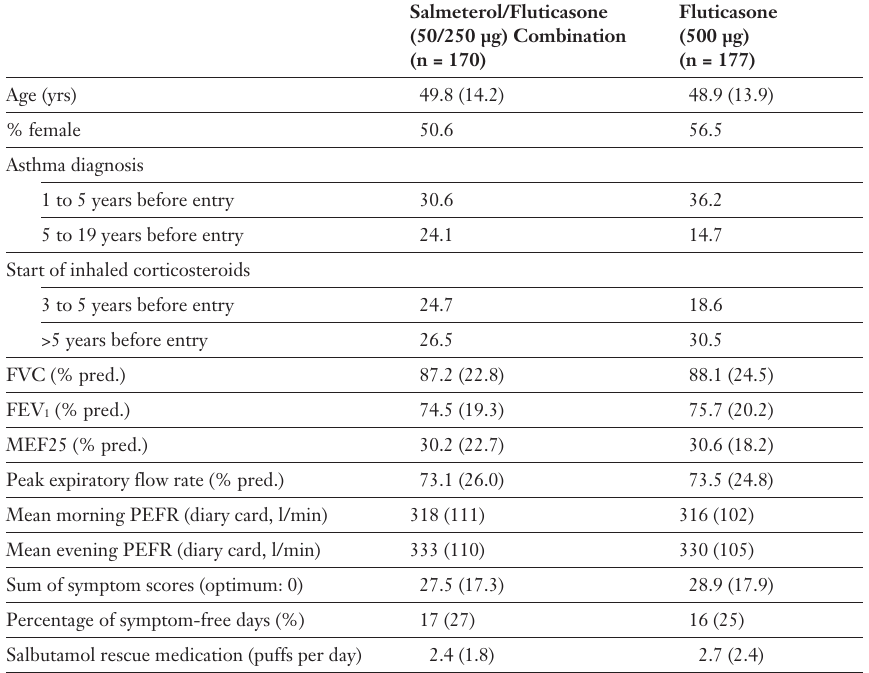
Demographic data, respiratory function tests and diary card data at randomisa- tion (means and stan- dard deviations).